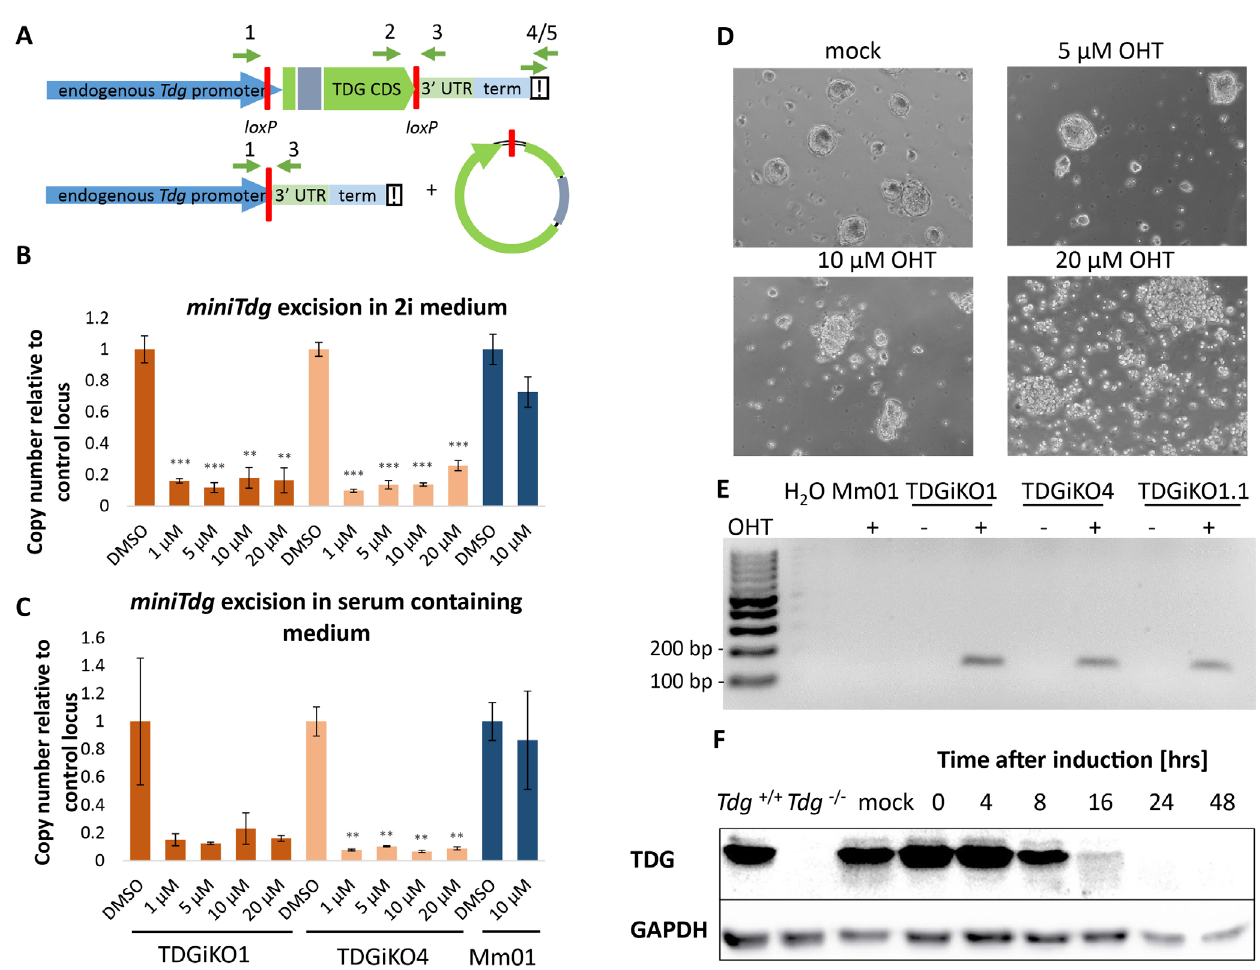
Figure 2. Cre induction for two hours results in the depletion of TDG within 24 hours without affecting cell viability. ( A ) Scheme of the miniTdg cassette before (top) and after (bottom) Cre-mediated recombination. Position of PCR primers are indicated with green arrows. ( B ) Quantitation of miniTdg excision upon OHT administration in TDGiKO1, TDGiKO4 and parental ESCs without the Cre recombinase (Mm01). Genomic DNA of cells was extracted two days after OHT treatment with indicated concentrations for 2 hours. Copy number